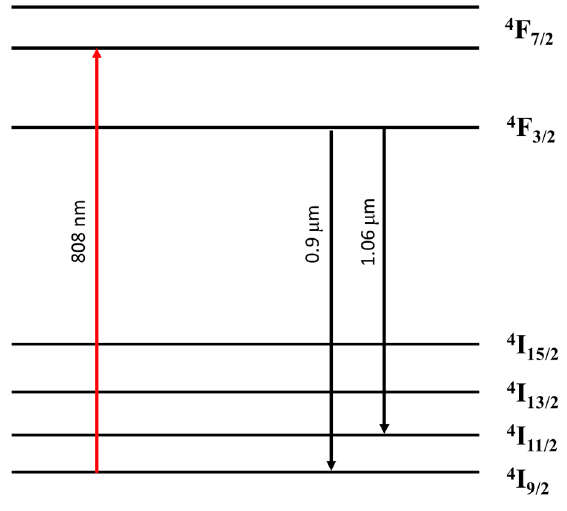
Figure 3. Energy level structure of Nd 3+ in Nd:YAG.